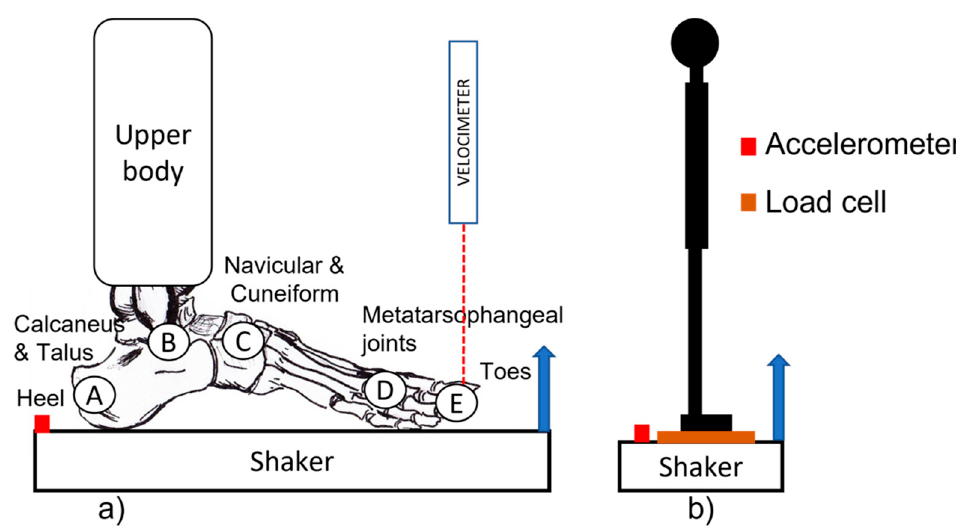
Figure 2. ( a ) Schematic representation of the experimental setup used to measure foot transmissibility. An accelerometer measured the vertical acceleration at the vibrating plate while a velocimeter measured the output velocity at 24 locations that can be grouped into zones from A to E [15,17]. ( b ) Schematic representation of the experimental setup used to measure apparent mass. A load cell measured the force at the driving point while an accelerometer measured the vertical acceleration [16].